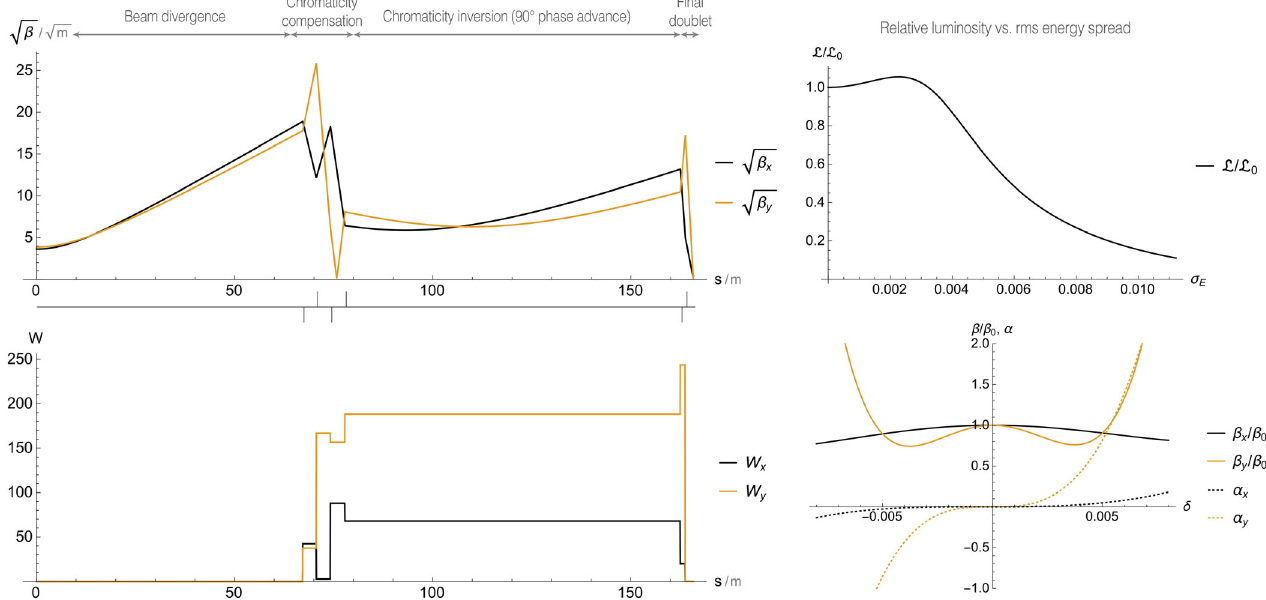
FIG. 6. Example B: Final focus. A 166 m long first-order apochromatic lattice using 6 (thin) quadrupoles, focuses a beam of 0.5% rms energy spread with about 30% luminosity loss. The beam is focused from β β (cid:2) 1 . 33 cm, in total a β -demagnification of 80 in x and 1125 in y . The W -function is intentionally increased, then transported and y ¼ inverted, until it is finally canceled in the final doublet, which focuses the beam to the interaction